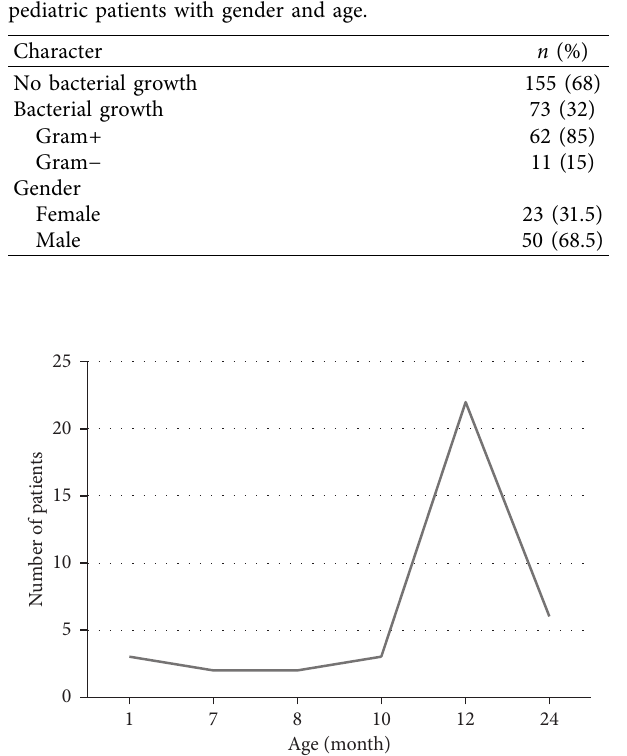
Figure 1: Frequency of age distribution in the pediatric patient’s positive ocular swabs.